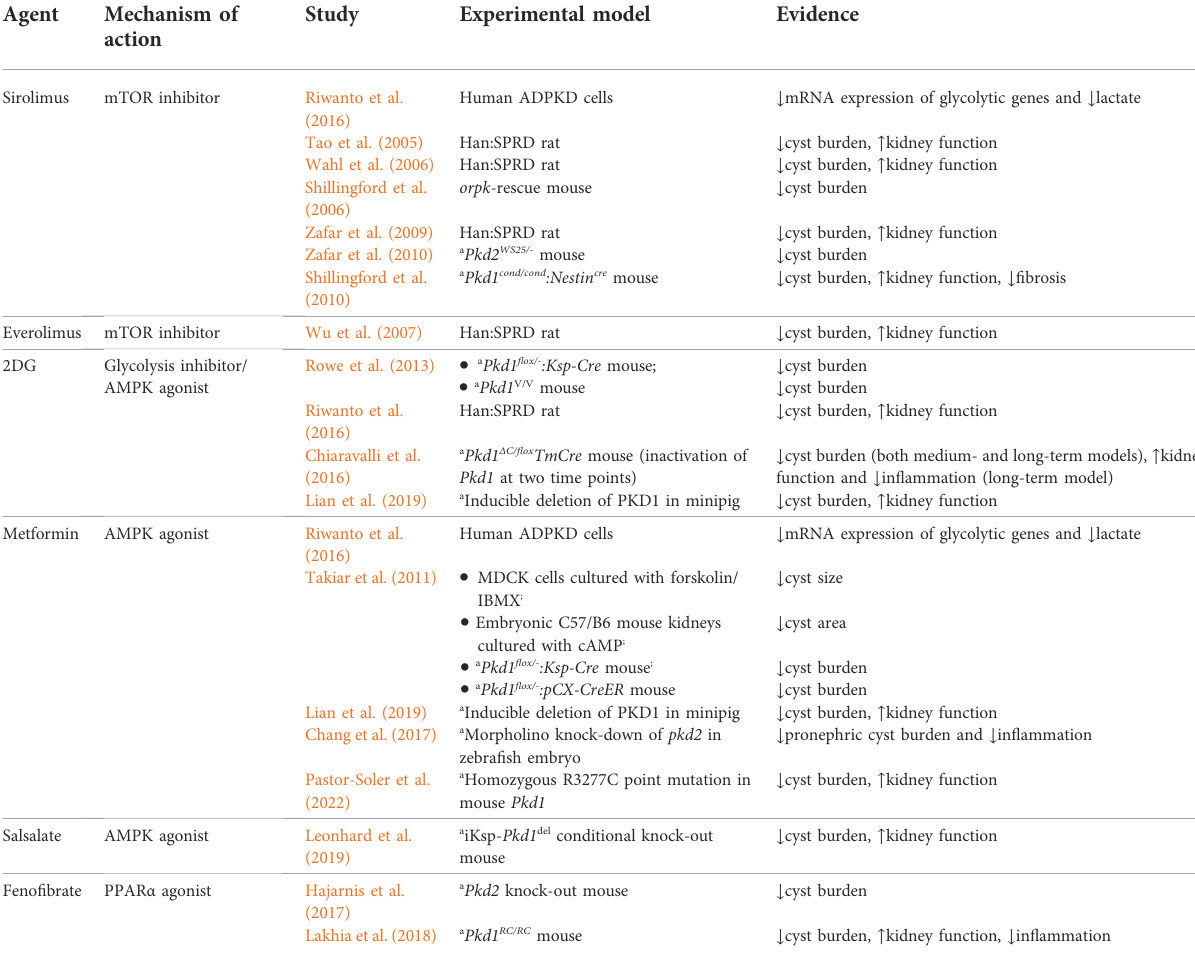
TABLE 1 In vitro and animal studies investigating metabolic agents of interest in the treatment of